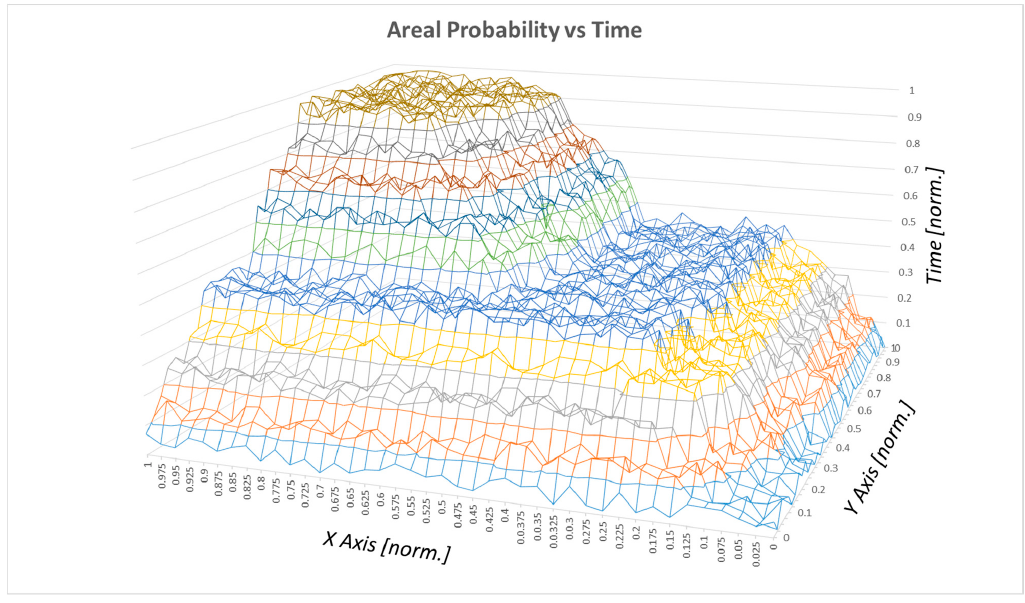
Figure 6. Surface probability vs. time.